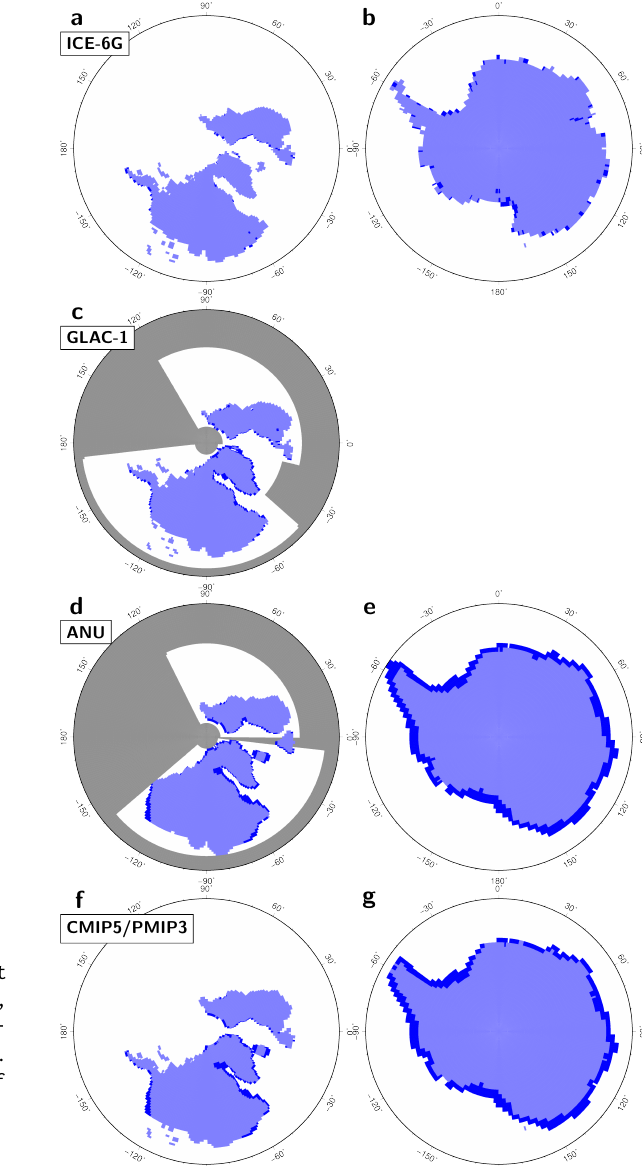
Figure 5. Ice-shelf extent at the LGM from the ice-shelf masks for the Northern Hemisphere derived from ICE-6G v.2 for (a) the Northern Hemisphere and (b) Antarctica, from GLAC-1a (c) for the Northern Hemisphere, and from ANU for (d) the North- ern Hemisphere and (e) Antarctica. The GLAC-1a reconstruction for Antarctica is identical to that of ICE-6Gv.2, and is there- fore not shown. These reconstructed masks can be compared with the CMIP5/PMIP3 mask for (f) the Northern Hemisphere and (g) Antarctica. Cyan, blue and white areas indicate the grounded- ice, floating-ice and ice-free regions,